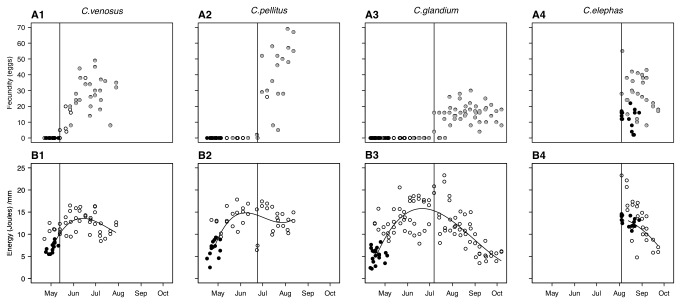
Seasonal dynamic of the whole-body energy budget of wild-caught females belonging to the four Curculio species.Upper row (A): Number of oocytes contained in the females ovaries. Mated and virgin females are distinguished according to the occurrence of sperm in their spermathecae and are individually represented with full grey and black circles, respectively. Lower row (B) shows total energy budget of female insects. Newly-emerged (full black circles) and lived-trapped females (open circles) are shown. For each species, the vertical line represents the starting date of oogenesis (C. venosus 05/13/2009 -m/d/y- ; C. pellitus 06/23/2009; C. glandium 07/07/2009; C. elephas 08/05/2009).